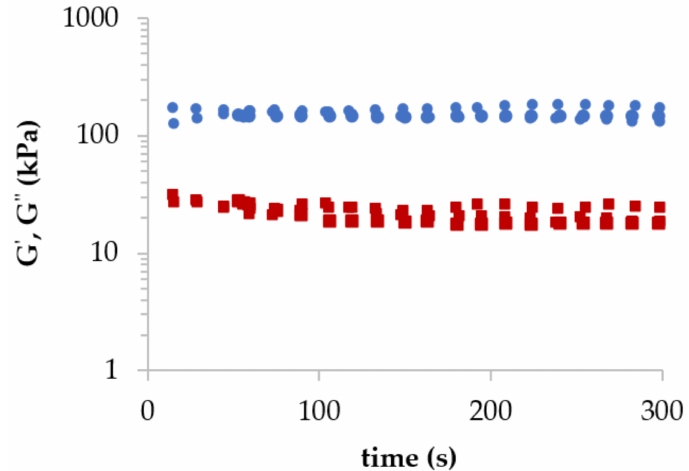
Figure 2. Storage modulus G’ (circles) and loss modulus G” (squares) as a function of time for HiG 427 alginate gel at 4% ( w / w ) of alginate concentration and 100 mM of CaCl 2 at 23 ◦ C ( n = 3).